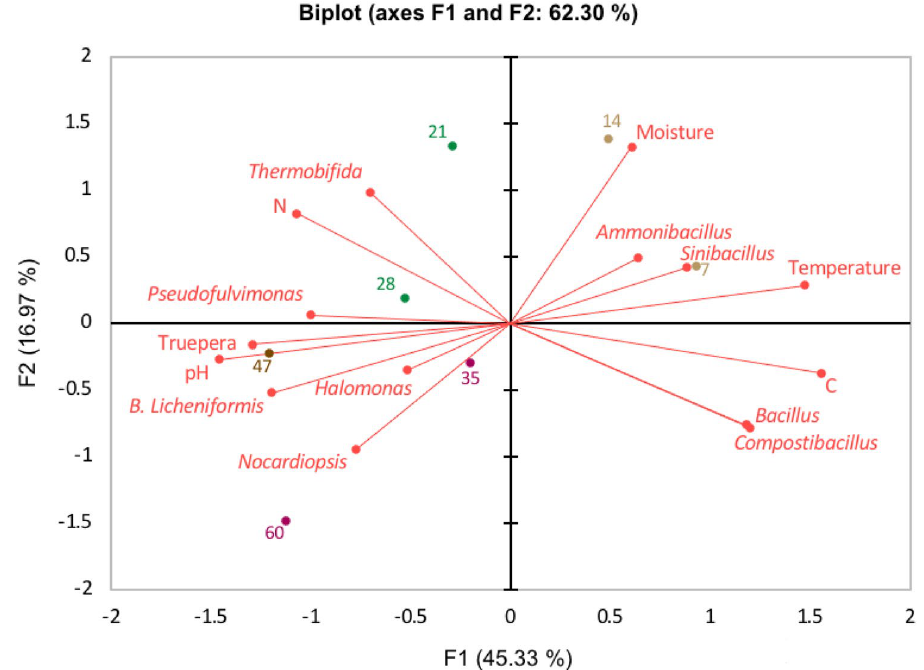
Figure 3. Principal component analysis (PCA) indicates the correlation and distribution of the samples between dominant phyla and physicochemical parameters during the composting with biochar. Interpretation of the data analysis was explained by Biplot. Original variables (dominant phyla and physicochemical characteristics) drawn as vectors (red line) was used to summarize the correlation between the variable. Clustering of the sample site due to the bacteria community composition and composting stages are highlighted by green, brown, and dark red dots. F1 and F2 axes represent 62.3% of the explained